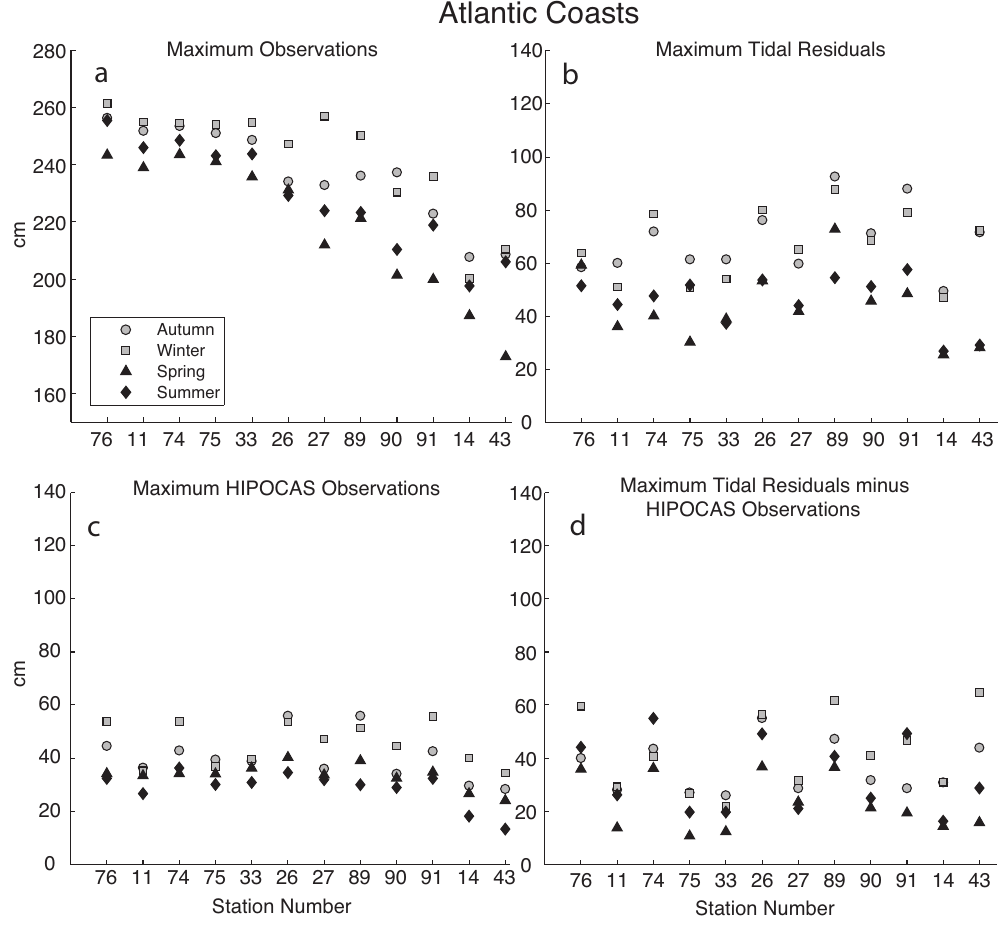
Figure 3. Maximum seasonal values in the Atlantic coasts. Observations (a), tidal residuals (b), model (c) and tidal residual minus model values (d) for each season. The x-axis corresponds to the station number.